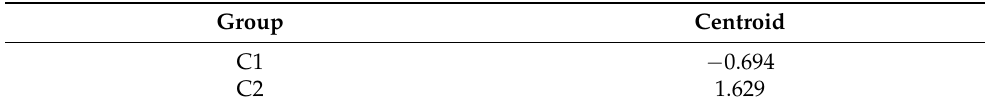
Table 5. The group centroids of the discriminant function. Group